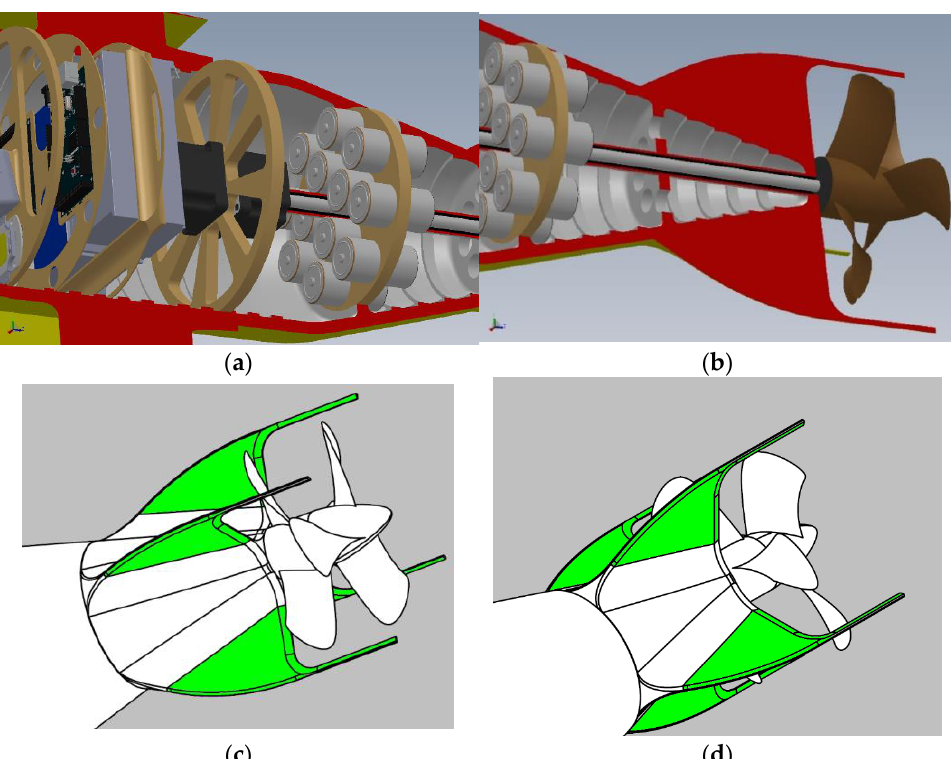
Figure 6. Drone cutaway side view ( a ) engines bay; ( b ) propulsion bay. Fins arrangement: the movable parts are green. Prospective view: ( c ) port side ( d ) starboard side.